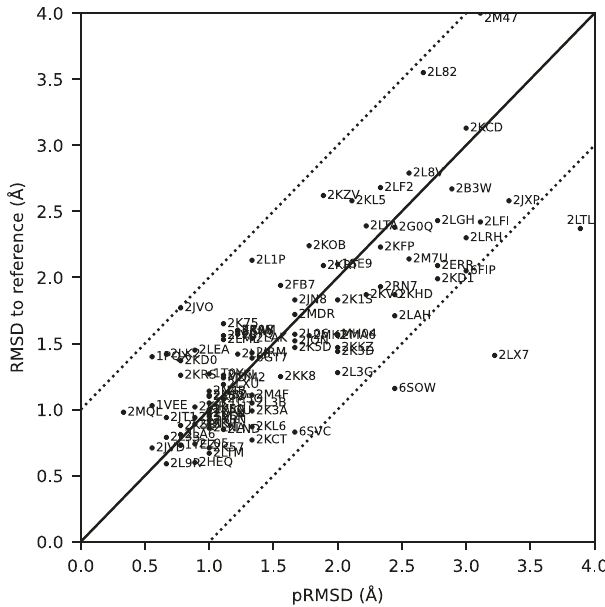
Fig. 5 | Actual and predicted RMSD between ARTINA and reference PDB structures. The predicted RMSD to reference (pRMSD) is calculated from the ARTINAresultswithout knowledge of thereferencePDBstructure(see “ Methods ” ) and, by de fi nition, always in the range of 0 – 4Å. For comparability, actual RMSD valuestoreference arealsotruncated at4Å(protein2M47withRMSD4.47Å).The dotted lines represent deviations of ±1Å between the two RMSD quantities.